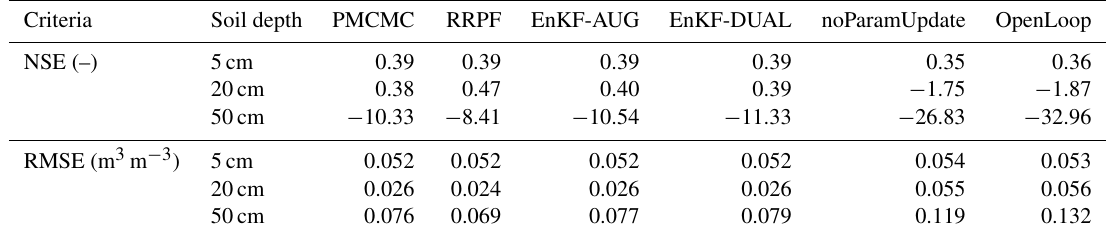
Table 5. Evaluation period: values of the NSE and RMSE summary statistics of the quality of fit of VIC-3L for the Rollesbroich soil moisture observations at 5, 20, and 50cm depths using the calibrated parameter values and initial states derived from the PMCMC, RRPF, EnKF-AUG and EnKF-DUAL data assimilation methods. For completeness, we also list the performance of the EnKF using state estimation only (noParamUpdate) using VIC-3L parameter values drawn randomly from the prior parameter distribution, and the performance of an open-loop run of VIC-3L (OpenLoop) using the mean simulation of many different VIC-3L parameterizations drawn randomly from the prior parameter distribution.